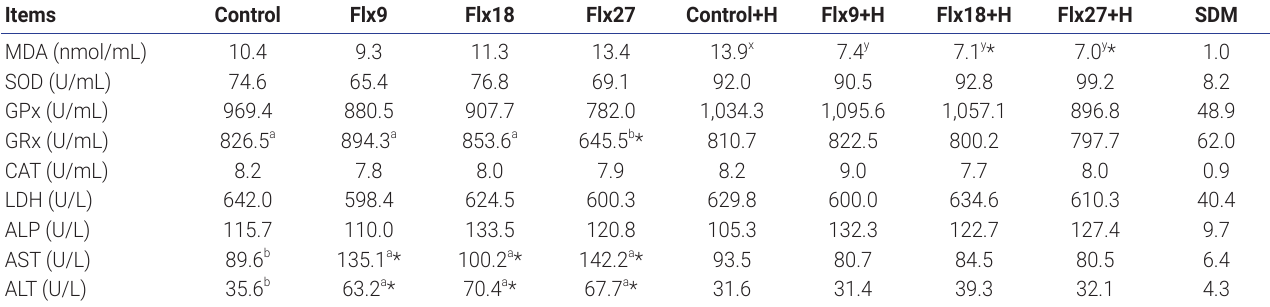
Table 7. Antioxidant and serological enzymes of laying hen were fed test diets with different levels of ex-truded flaxseed with and without herbal medicines for nine weeks